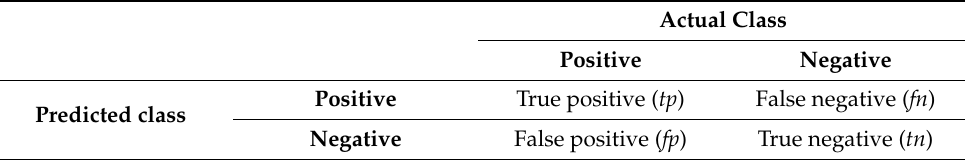
Table 2. Confusion